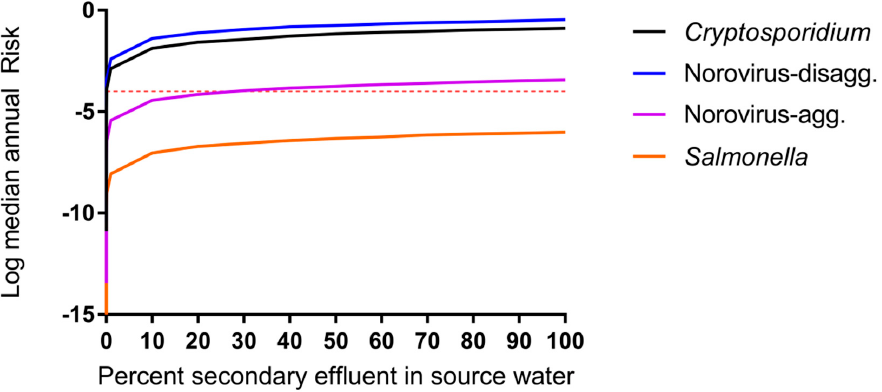
Figure 4. Impact of surface water quality on DPR risk modeled as percent of source (surface) water comprised of secondary treated wastewater effluent (Treatment train scenario (1), de facto reuse, case b, F blend = 1, 0 < F dilution < 1). Median annual risks shown for each pathogen. Microbial risk is driven by surface water quality even when supplies are impacted by 1% secondary treated wastewater effluent.